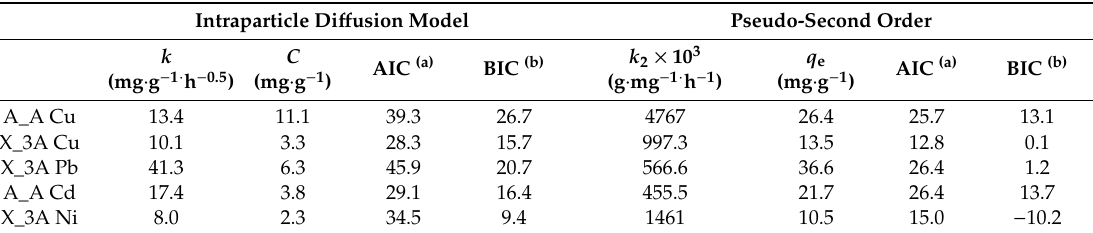
Table A1. Parameters of kinetic models for the fast step of the kinetic